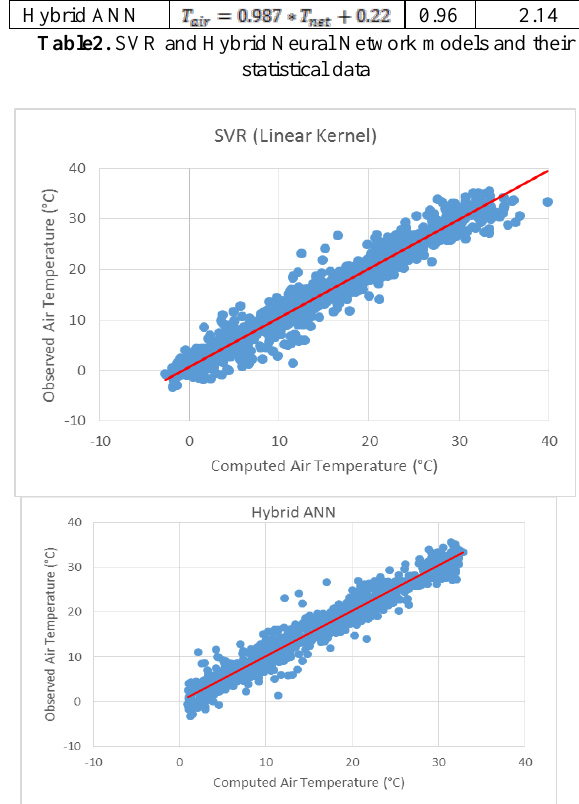
Figure8. Plots of model predicted air temperature against observed ones for SVR and Hybrid ANN